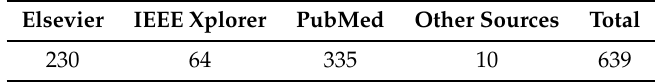
Table 3. Step 3: Relevant articles after screening of ISI Web of Science Indexing.